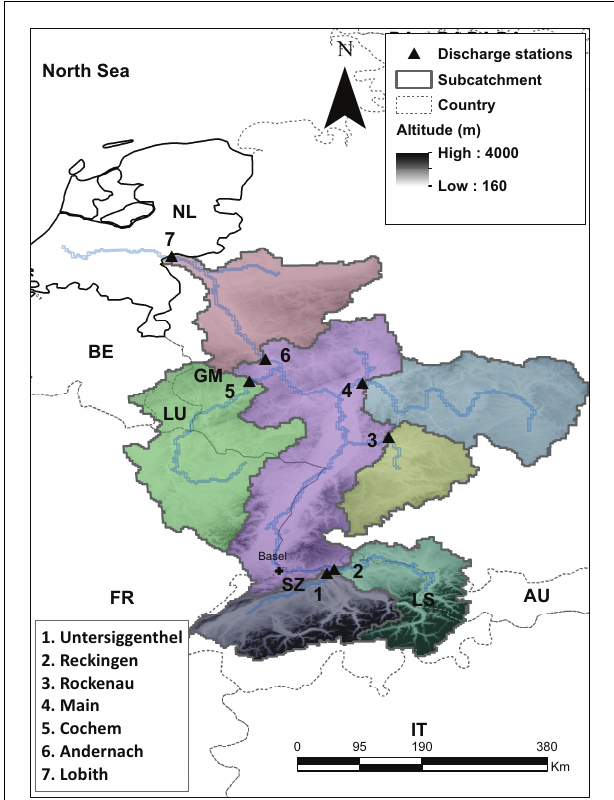
FIGURE 1 | The Rhine basin, with seven sub catchments used for the calibration in the study. The triangles (black) represents the outlet of sub-basin used for the calibration. The two letter abbreviations are used to denote the countries. The blue line represents the Rhine and the tributaries. The black boundary represents the Netherlands